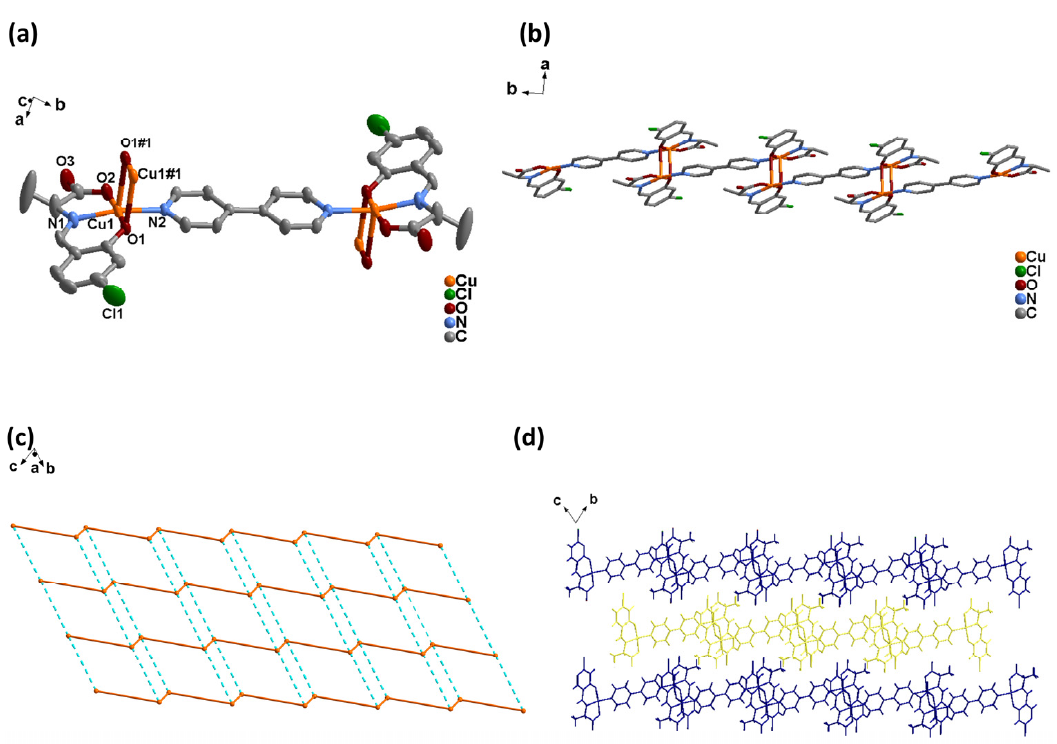
Figure 2. ( a ) Coordination environment presentation of 2- S with 50% thermal ellipsoid probability (hydrogen atoms have been omitted for clarity); symmetry mode: #1: x, y, 1 + z; ( b ) 1D structure of 2 - S as viewed from the a axis; ( c ) 2D topological structure of 2- S as viewed from the a axis, the blue dotted line denotes the hydrogen bond; ( d ) the 3D supramolecular structure of 2 -S is packed in an ABAB form via van der Waals forces from the b axis.